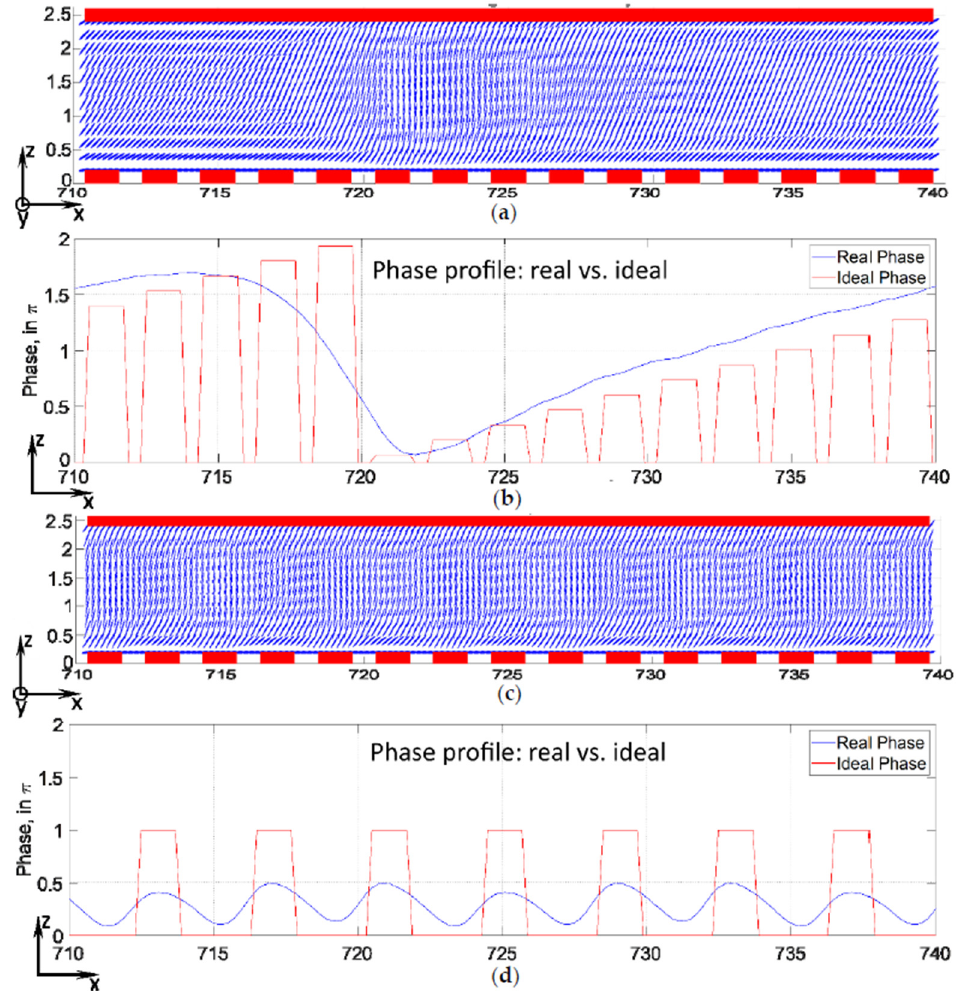
Figure 5. Visualization of simulation results for a blazed grating formed in the LC cell: ( a ) distribution of LC directors (in XZ ‐ plane, cross ‐ section) in the “on ‐ state”, when each electrode has reached its target voltage level, at a diffraction angle of 1.5°; ( b ) real (curves) and ideal phase profiles (columns) at the same length, at a diffraction angle of 1.5°; ( c ) distribution of LC director (in XZ ‐ plane, cross ‐ section) in the “on ‐ state”, when each electrode has reached its target voltage level, at a diffraction angle of 7.47°; ( d ) real (curves) and ideal phase profiles (columns) at the same length, at a diffraction angle of 7.47°.